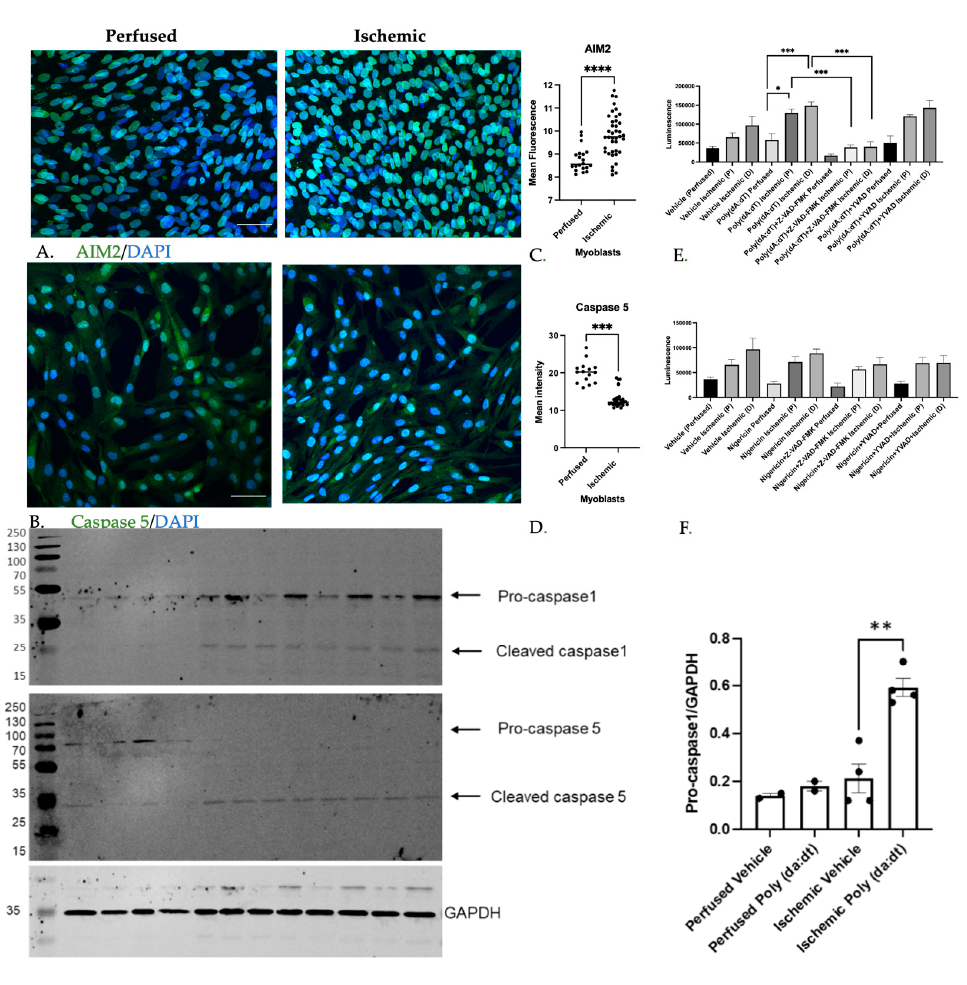
Figure 4. AIM2 expression was elevated and promoted inflammatory caspase activity in ischemic myoblasts. Expression of AIM2 and caspase-5 (total) were calculated in perfused and ischemic my- oblasts using immunofluorescence. DAPI was used to detect nuclei, and mean intensity per cell was calculated using ImageJ for a total of 5 images per cell group (N = 2 control, N = 3–4 ischemic). ( A , C ) AIM2 immunofluorescence and quantification (**** p < 0.0001); ( B , D ) caspase 5 (*** p < 0.001). Lumi- nescence assays were used to detect inflammatory caspase activity induced by caspase-1, -4, and -5 in perfused and ischemic cells with and without either caspase-1-specific or additional pan-caspase inhibition. Cells were additionally exposed to ( E ) poly(dA:dT), an AIM2 agonist (* p < 0.05, *** p < 0.001) and ( F ) nigericin, an NLRP3 agonist. Scale bar = 10 μ M. ( G ) Detection of pro-and cleaved caspase 1 and caspase 5 by Western blots performed with perfused and ischemic myoblast with and without poly(dA:dT). ** p < 0.002 (N = 2 perfused, 4 ischemic). 3.1.3. Caspase Inhibition Reduced Myocyte Differentiation in Ischemic Myoblasts We showed that myoblasts from ischemic regions of skeletal muscle demonstrated attenuated differentiation and increased caspase activity induced by AIM2 inflammasome activation. Caspase activity is also important for release of HMGB1 from differentiating myoblasts. While HMGB1 is a pro-inflammatory signal, it also promotes muscle regener- ation [26]. We therefore asked whether blocking caspase activity would influence capacity of myoblasts to differentiate, potentially as a function of reduced HMGB1 release. To an- swer this question, we treated myoblasts isolated from perfused or ischemic regions with Z-VAD-FMK and assessed myocyte fusion. Exposure to Z-VAD-FMK reduced myocyte fusion index in ischemic but not in perfused cells (Figure 5A,B).